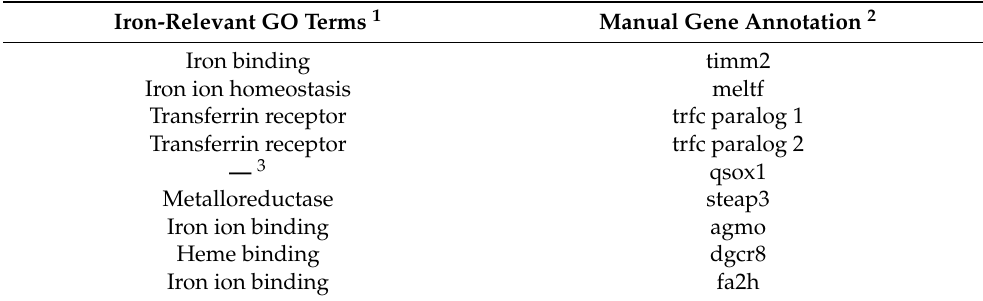
Table 2. Nine genes with IRE motifs and GO terms or other annotation associated with iron metabolism.